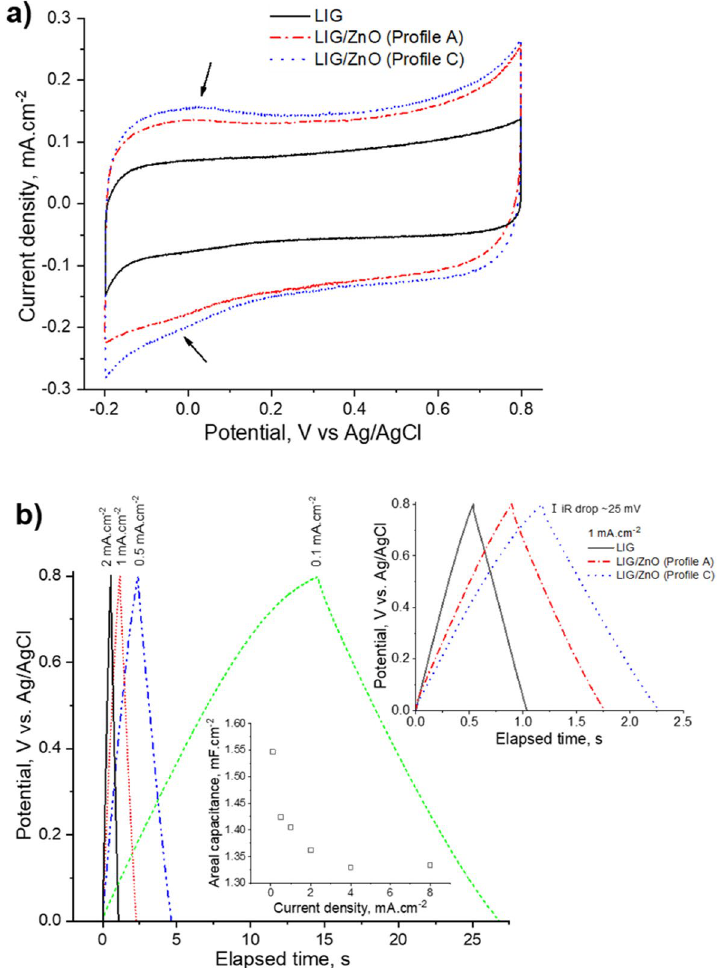
Figure 4. ( a ) Cyclic voltammograms in 1 M KCl aqueous solution. The scan rate is 0.1 V s −1 . ( b ) GCD curves for the LIG/ZnO (profile C) electrode. The capacitance dependence on the current density (bottom inset) and the comparison with bare LIG and LIG/ZnO (profile A) electrodes (top right inset) are also